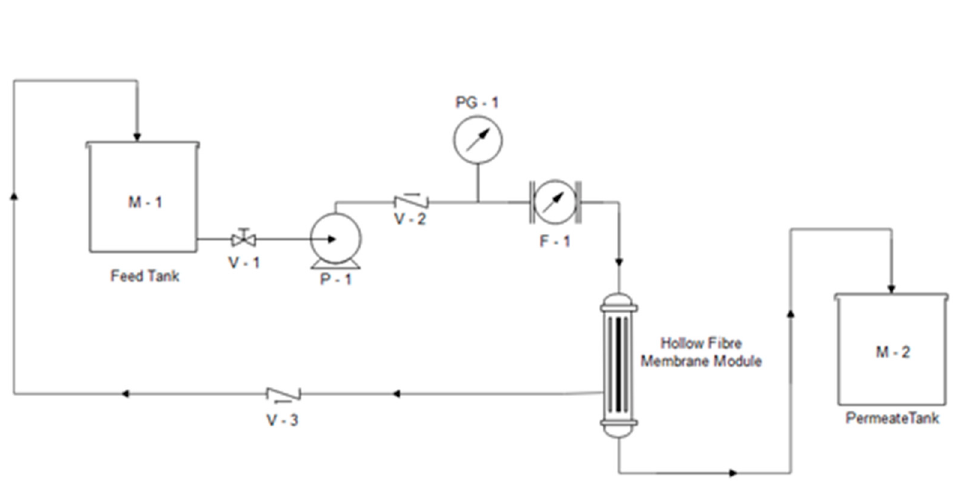
Figure 1. Schematic diagram of the adsorptive hollow fiber ceramic membrane (HFCM) system setup [30] .